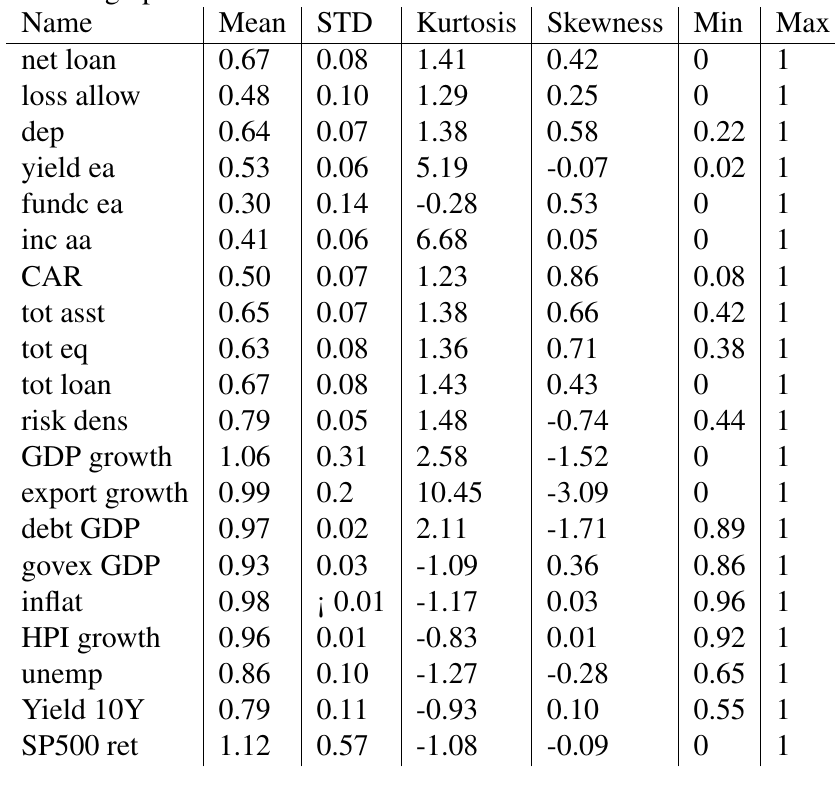
Table 3: Main statistics of overall financial and macro-economic indicators after pre-processing